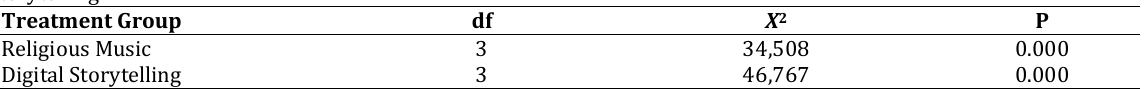
Table 9 Friedman Test Differences in Breath Frequency Before and After Being Given Religious Music and Digital Storytelling